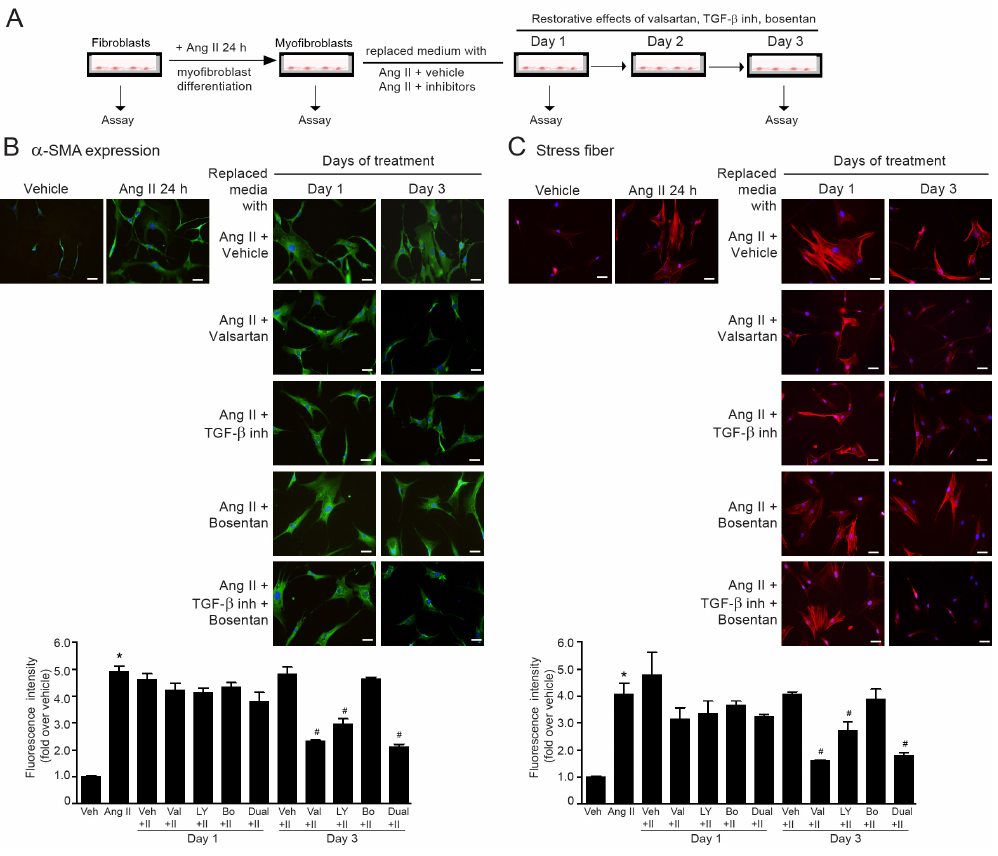
Figure 7. Restorative effects of ARB, TGF- β inhibitor, and ERA on Ang II-induced myofibroblast differentiation. ( A ) Experimental design and timeline of the treatment in cultured adult HCFs. ( B , C ) Fibroblasts were treated with 200 nM Ang II for 24 h to activate fibroblast-to-myofibroblast transformation. After 24 h, cells were replaced with media containing Ang II with different inhibitors, including valsartan, LY2109761, bosentan, and LY2109761 plus bosentan for up to 3 days. Analysis was performed on days 1 or 3 after cotreatment. At the end of treatment, immunofluorescence staining was used to determine α -SMA expression (green) ( B ) and stress fiber formation (red) ( C ). Nuclei were stained with DAPI (blue). Scale bar, 10 µm. Data are expressed as the mean ± SEM ( n = 3). * p < 0.05 vs. vehicle; # p < 0.05 vs. Ang II.